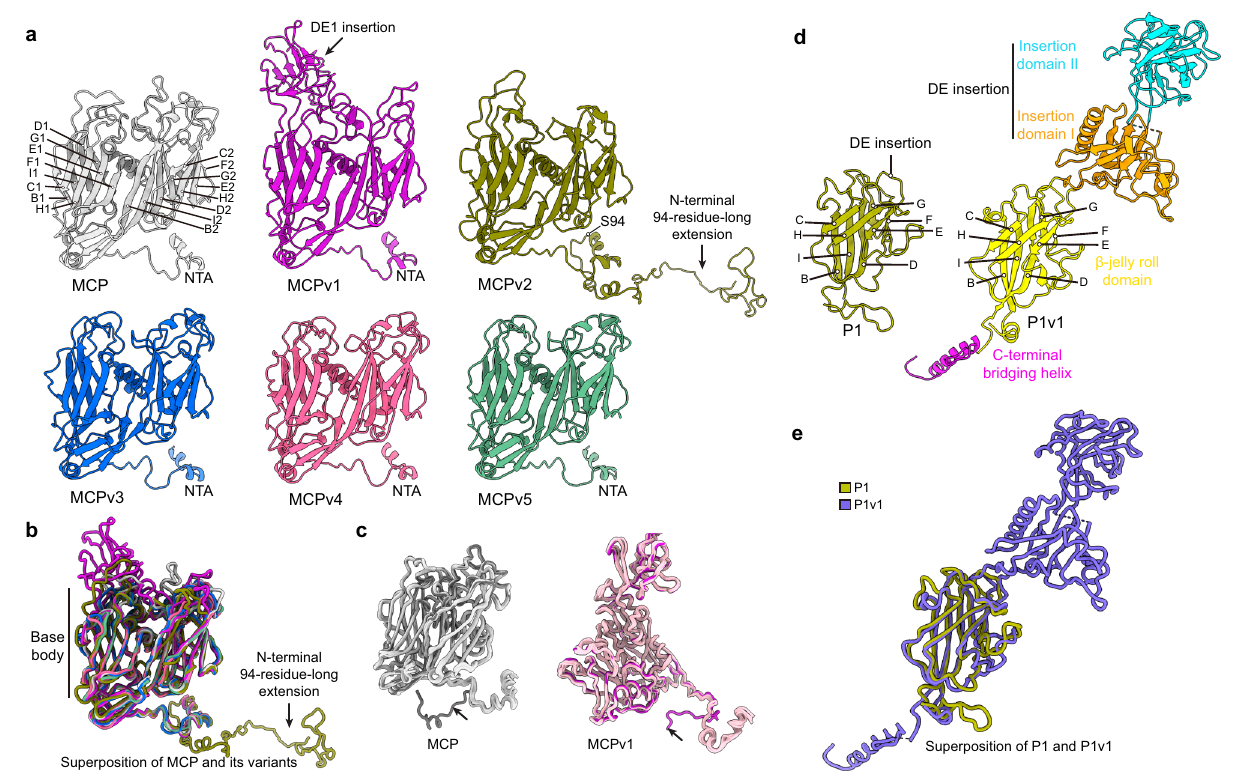
Fig. 2 | Structures of the MCP, MCP variants, penton protein, and penton protein variant. a Ribbon diagrams of the MCP and its variants. b Backbone superposition of MCP and its variants (MCPv1, MCPv2, MCPv3, MCPv4, and MCPv5),coloredasin a . c BackbonesuperpositionsofalltheMCPs(left)andallthe MCPv1s(right)inthepentasymmetronsoftheuniquevertex.Blackarrowsindicate